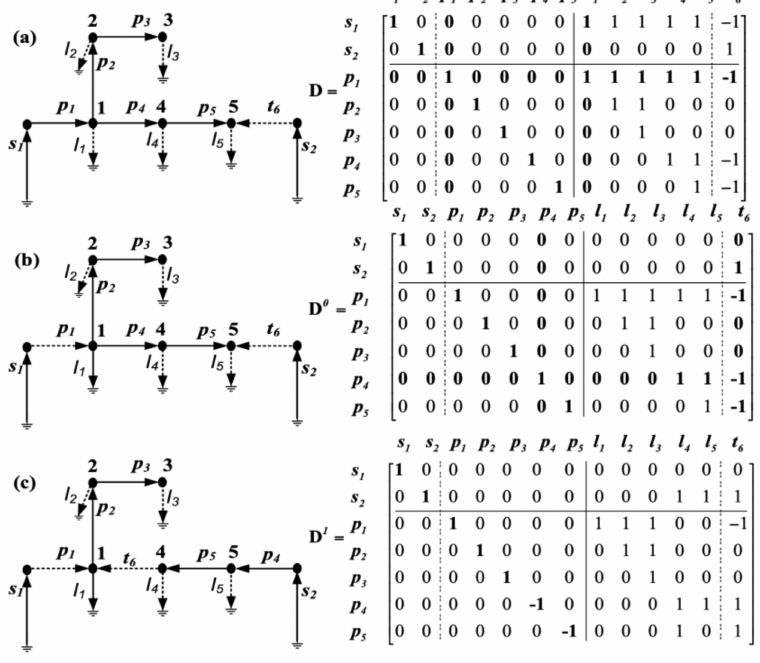
Figure 1. Circuit graph of a small network ( a ) in the up-state ( b ) in the down-state ( c ) in the partially restored